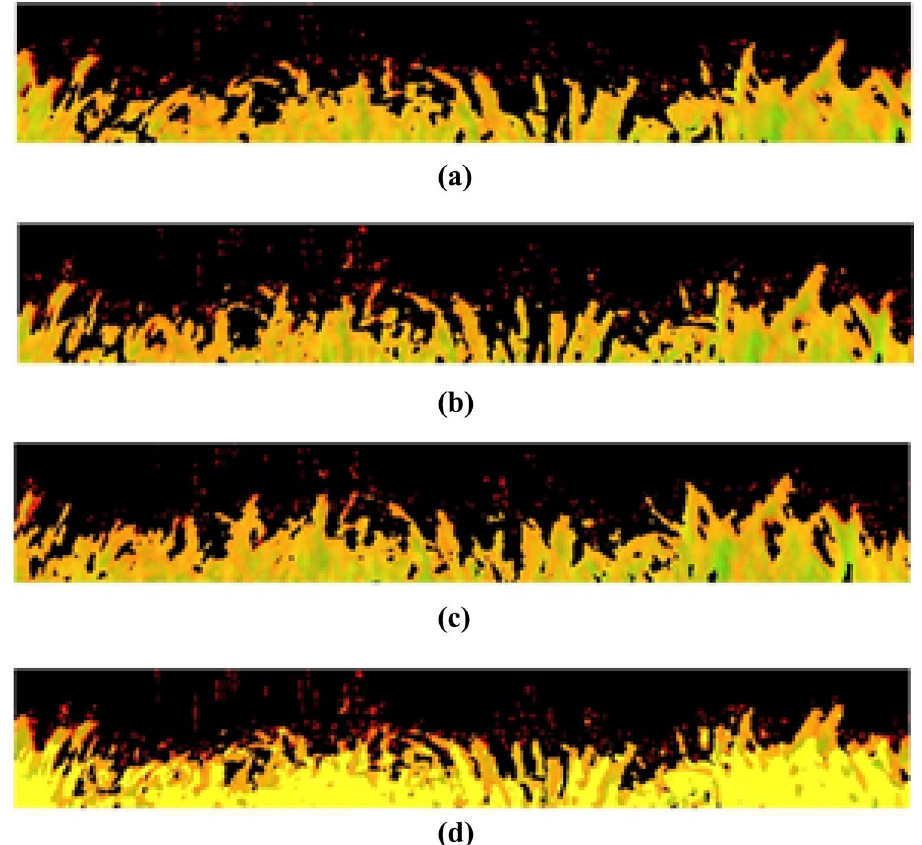
Fig. 5 Multi-frame summation to enhanced